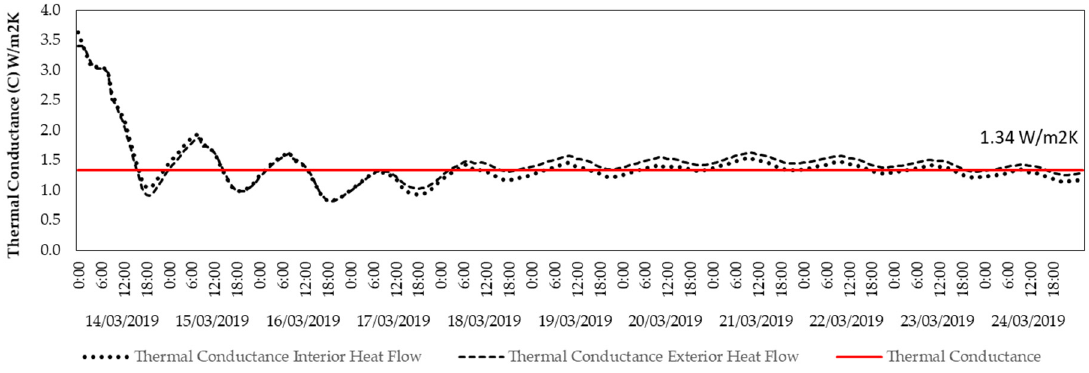
Figure 6. Thermal conductance W/m 2 . K filed from the on-site test data with the formula (5).